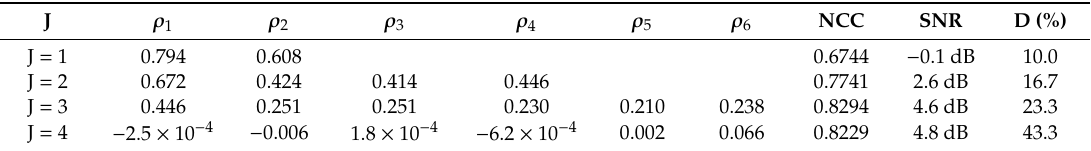
Table 1. Results at different decomposition scales.